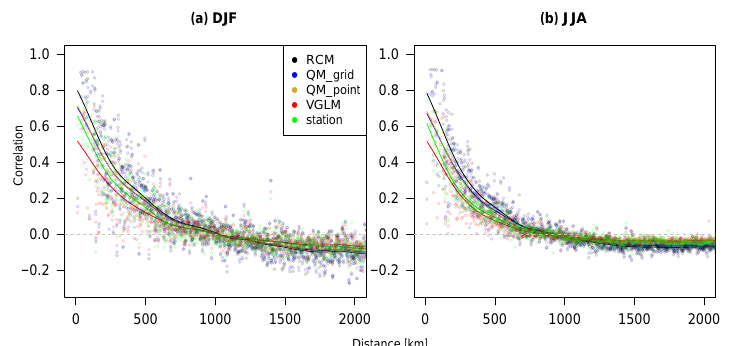
Figure 13. Spatial autocorrelation (cross-validated). Correlogram (circles) and smoothed spline fitted to the correlogram (lines) for (a) DJF and (b) JJA. The correlogram is estimated by the centered Mantel statistic using R package ncf (Bjornstad, 2015). For the VGLM 100 real- izations of the stochastic model for each station were used to estimate the